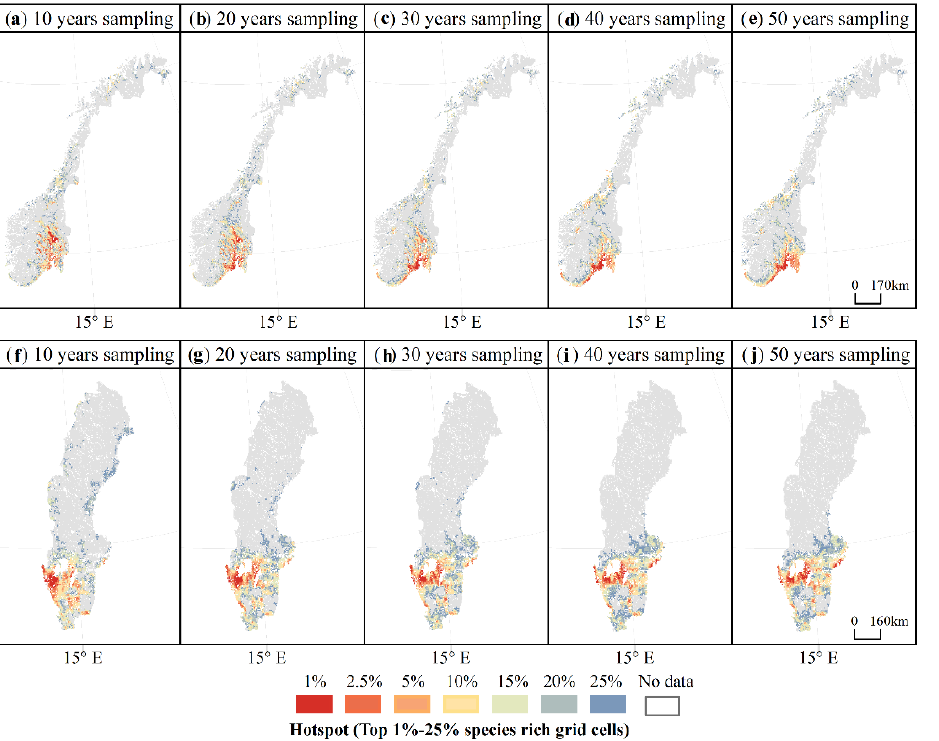
Figure 8. The distribution of the hotspots of macrofungal species richness predicted in each accu- mulated sampling period (i.e., sampling for 10 years (1970 – 1980), 20 years (1970 – 1990), 30 years (1970 – 2000), 40 years (1970 – 2010), and 50 years (1970 – 2020)) for ( a – e ) Norway and ( f – j ) Sweden.